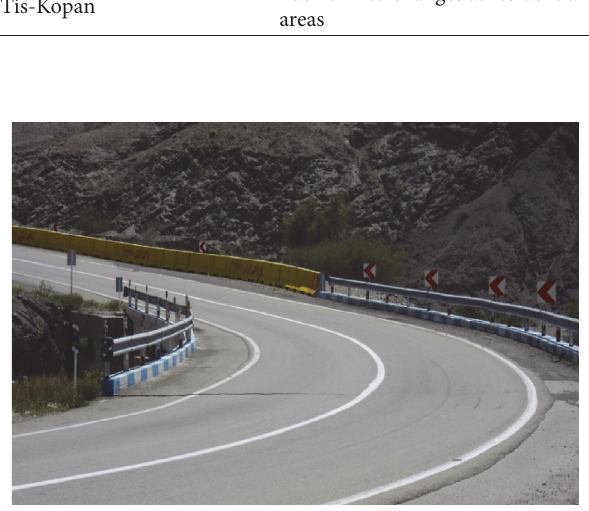
Figure 3: Section 5: Firouzabad.